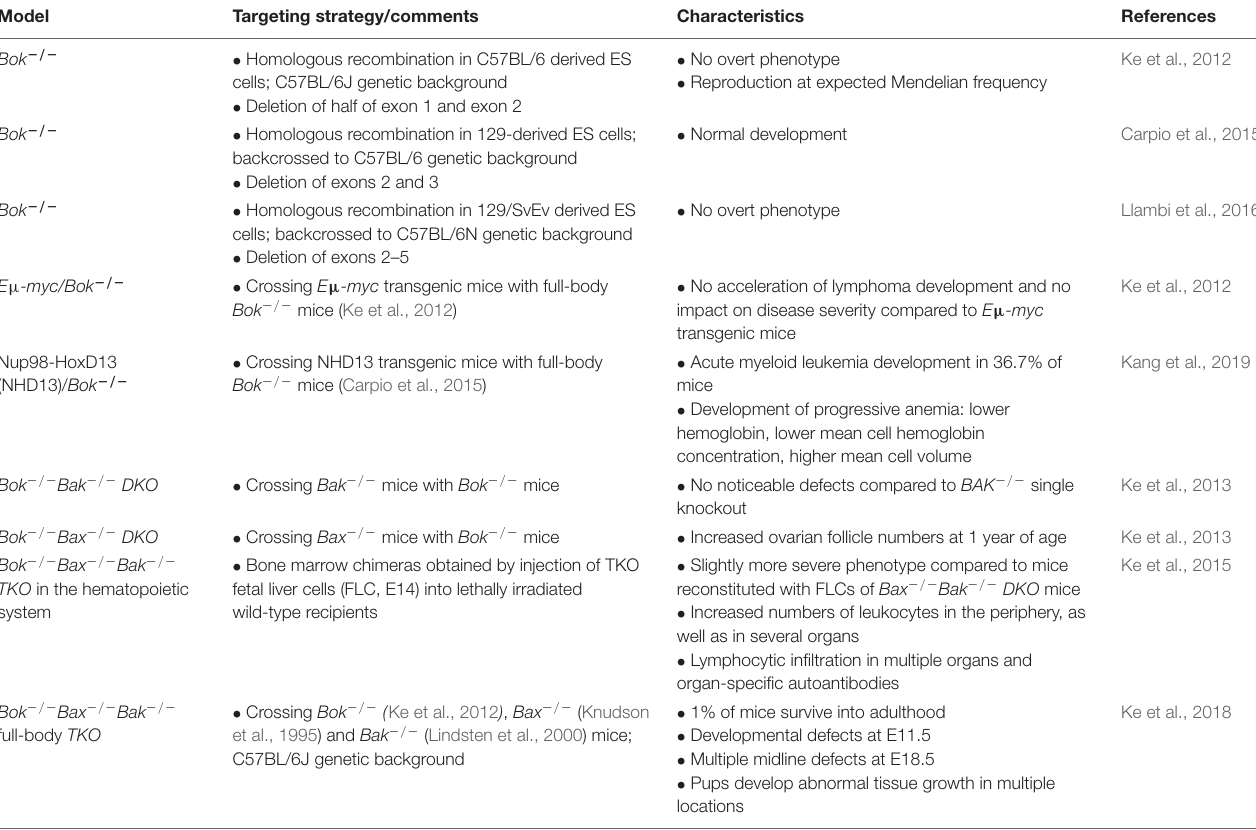
TABLE 1 | Bok -deficient mouse